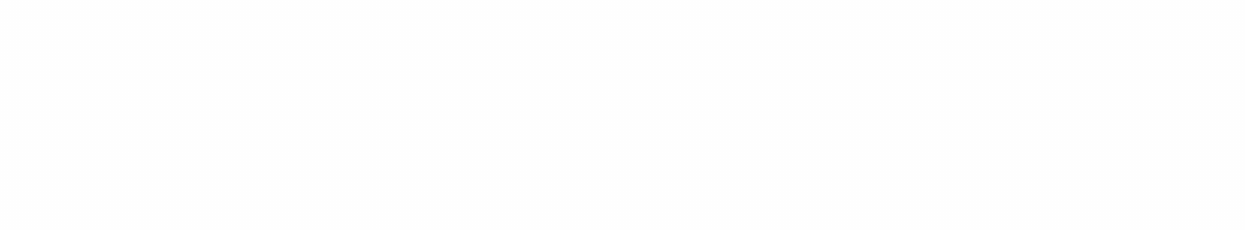
FIGURE 7 Amplitude of the main peak in the power spec- trum as a function of pL for the case vL=0.8, Ra--30, R1 Rr